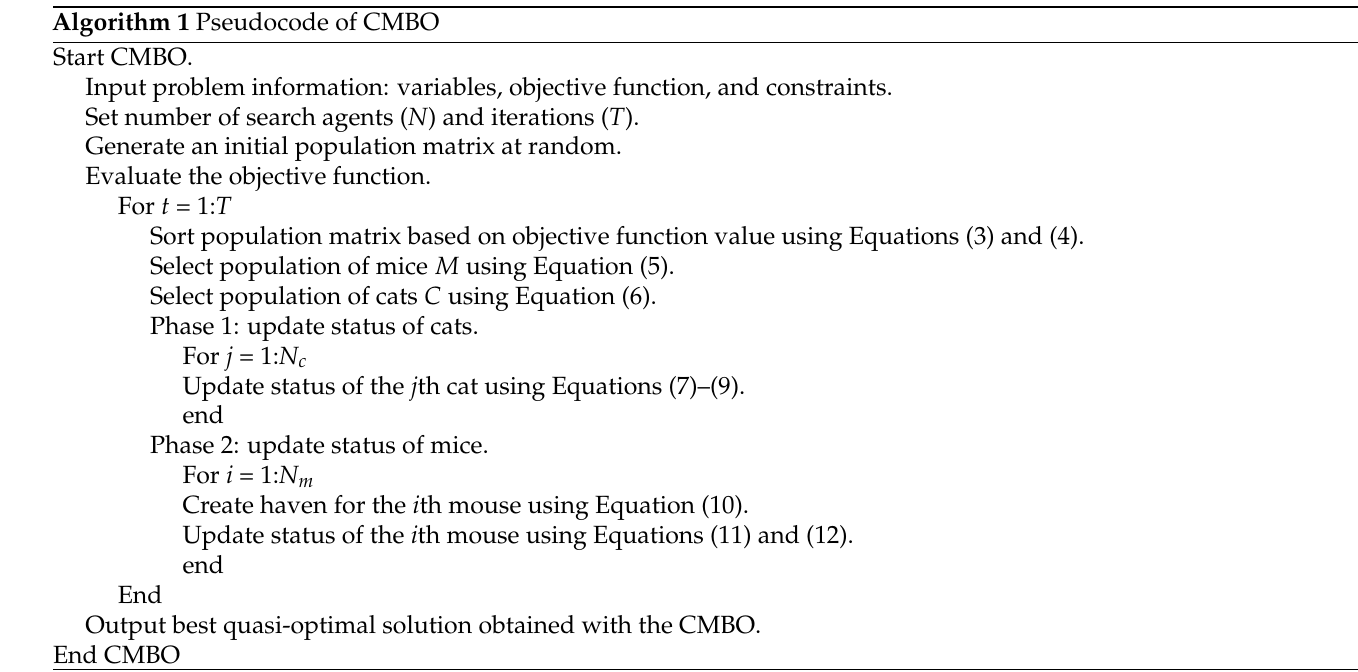
Algorithm 1 Pseudocode of